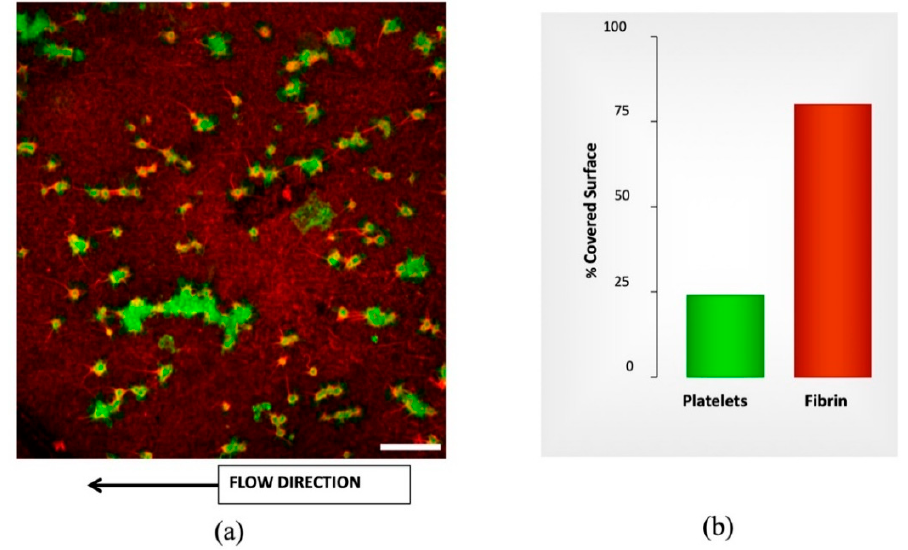
Figure 3. Confocal image labeled by immunofluorescence for morphometric analysis from microfluidic studies. ( a ) Confocal image showing platelets labeled byanti-CD36 Alexa Fluor 488 and Fibrin labeled by anti-fibrin(ogen) Alexa Fluor 594. The thrombogenic surface is a biomimetic combination with type-I fibrillar collagen (30.9 mg / cm 2 ) and tissue factor (0.95 ng / cm 2 ). Scale bar = 20 µ m. ( b ) The plot shows the quantification of platelet aggregates (green) and fibrin masses (red) interacting with the collagen / tissue factor surface. The bar graphs in the right panel summarize the results as percentages of the total surface exposed.